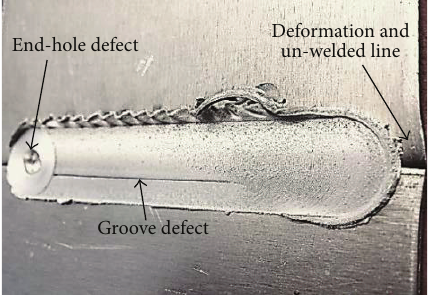
Figure 13: Conventional defect in